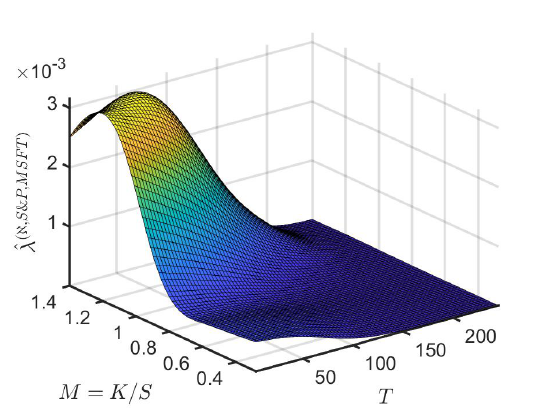
Figure 9. Implied information intensity against time to maturity T and moneyness M = K / S